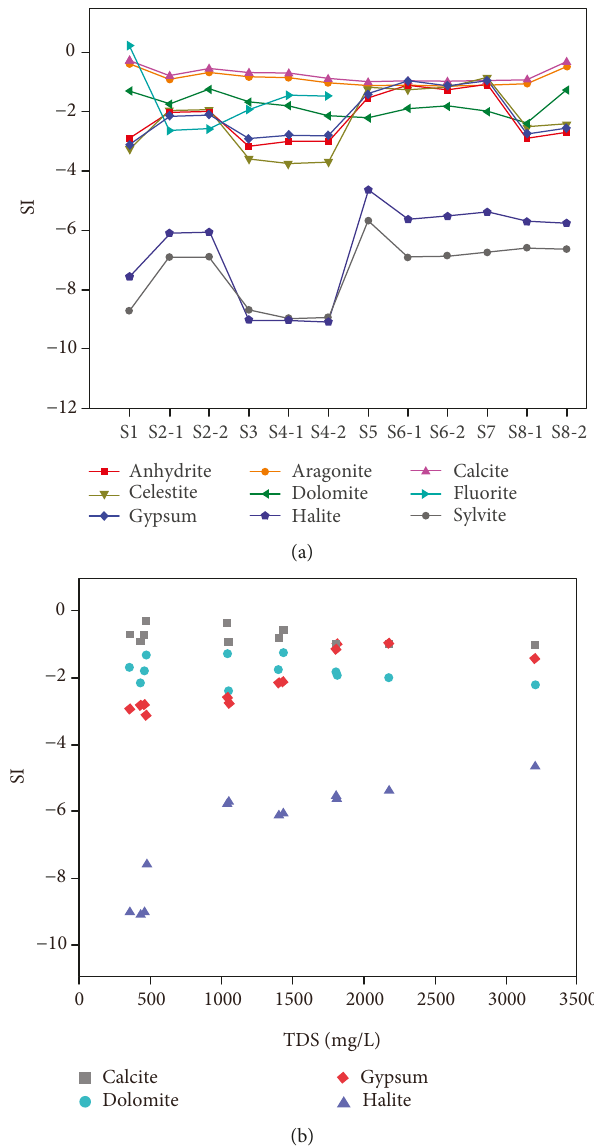
Figure 9: (a) Saturation indices of the main minerals for the springs in the Simao Basin; (b) evolution of saturation indices of calcite, dolomite, gypsum, and halite with